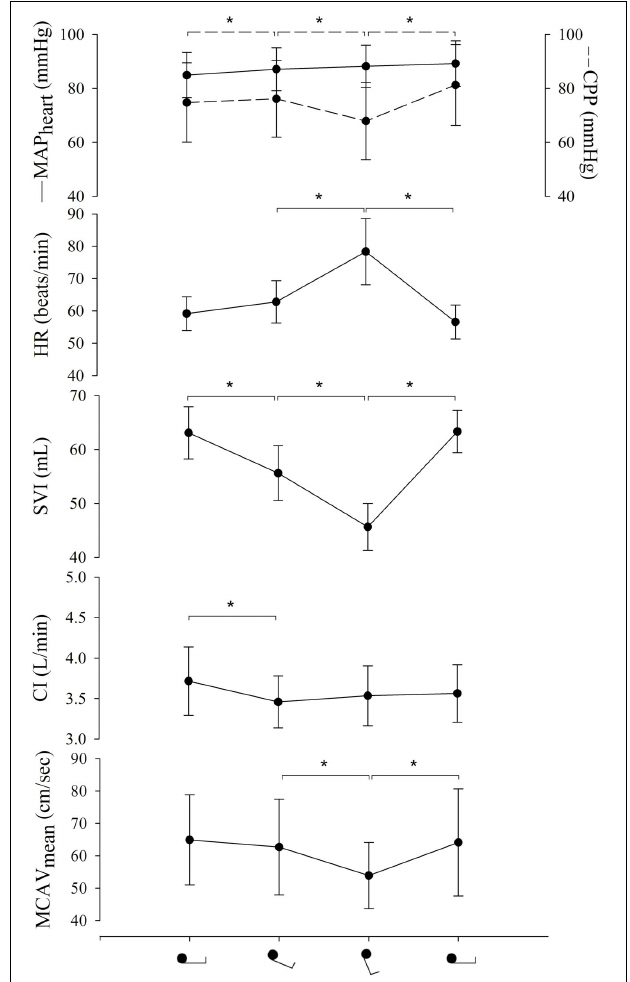
FIGURE 2 | Hemodynamic response to graded HUT and tilt back. MAP, mean arterial pressure; CPP, cerebral perfusion pressure; HR, heart rate; SVI, stroke volume index; CI, cardiac index; MCAV mean , mean middle cerebral artery flow velocity. ∗ p < 0 . 001.